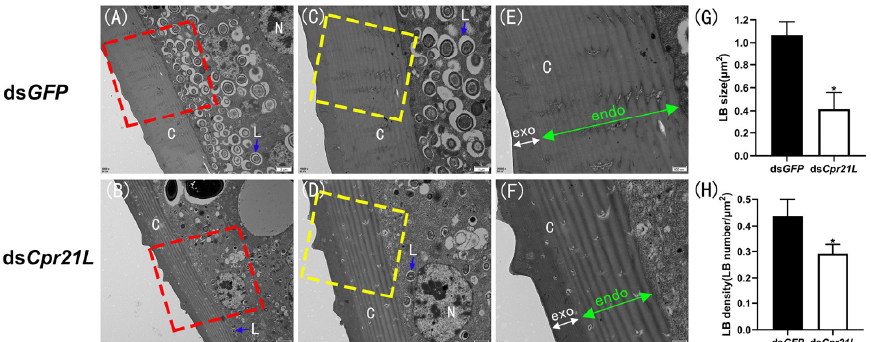
Figure 6. Transmission electron microscopy (TEM) observations of the abdominal cuticle of dsR ‐ NA ‐ injected BPHs. Nymphs were injected with dsRNAs at the 4th instar stage (1–12 h post ‐ molting) and then sampled 2 days later. ( C ) and ( D ) are magnifications of the areas marked with red ‐ dashed boxes in ( A ) and ( B ), respectively. Likewise, ( E ) and ( F ) are magnifications of the areas marked by the yellow ‐ dashed boxes in ( C ) and ( D ), respectively. Blue arrows, lamellar body ‐ like (LBL) structures. Scale bar = 2 μ m ( A , B ), 1 μ m ( C , D ), and 500 nm ( E , F ). ( G ) Size of LBL structures. ( H ) Density of LBL structures. Asterisks (*) on the bars in (G) and (H) indicate significant differences between the control (dsGFP) and the corresponding treatment group (*p < 0.05).